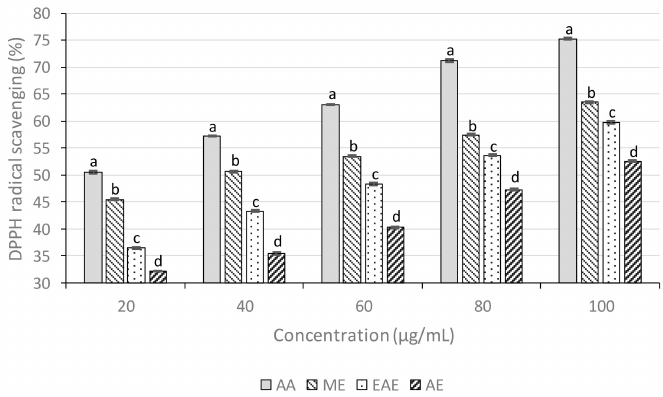
Figure 1. DPPH (2,2-diphenyl-1-picrylhydrazyl) radical scavenging activity of leaf extracts. Statistical significance was determined at p < 0.05 and is indicated with di ff erent letters (each concentration was evaluated